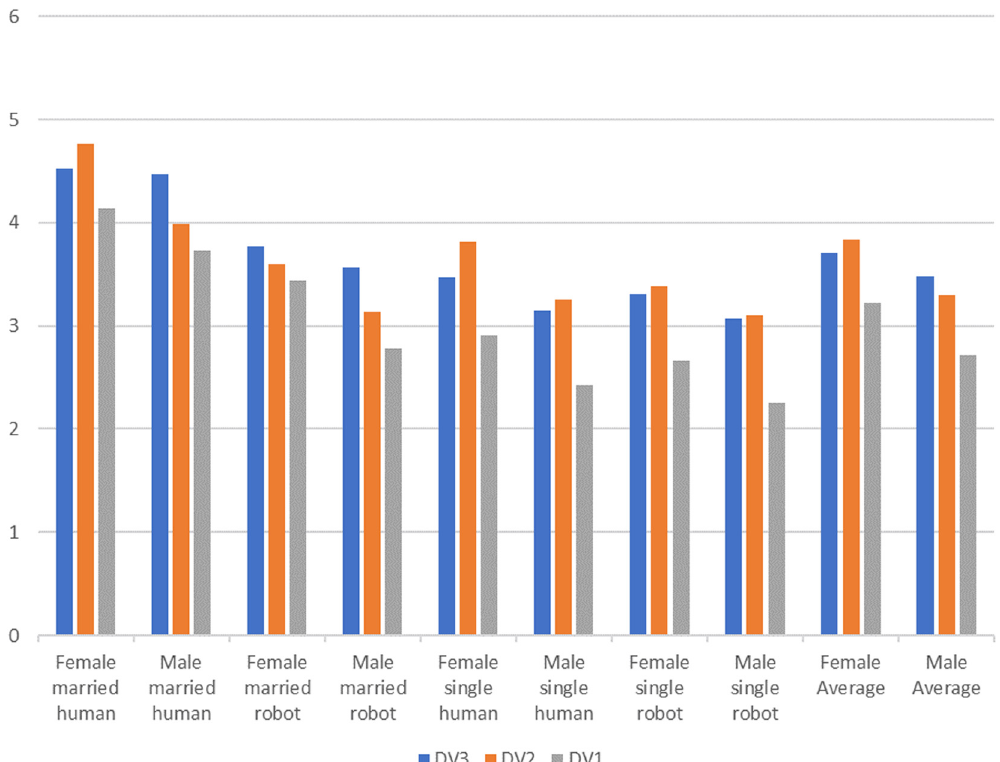
Figure 4: Gender di ff erence in rating DVs in all conditions in the main study. Notice how the level of condemnation by female subjects is always slightly higher than by male subjects but the pattern stays remarkably similar ( DV1: condemnation of the main characters actions, DV2: condemnation of purchasing sexual services, DV3: condemnation of the main character )